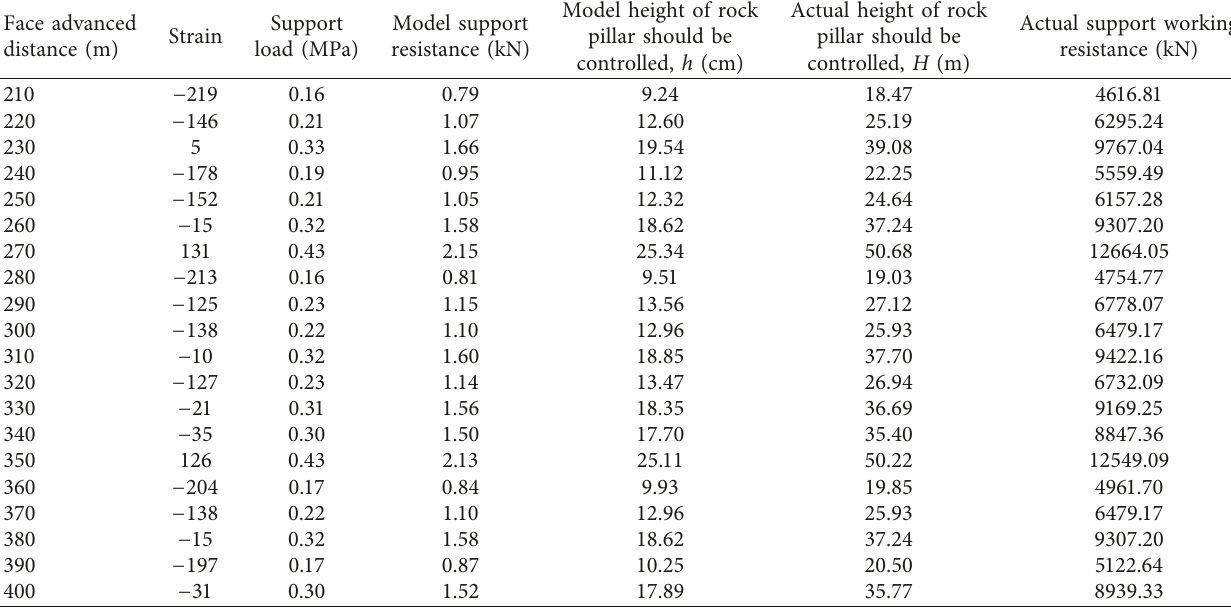
Table 5: Support working resistances obtained from the material simulation test in coal with a thickness of 9m. Face advanced distance (m)